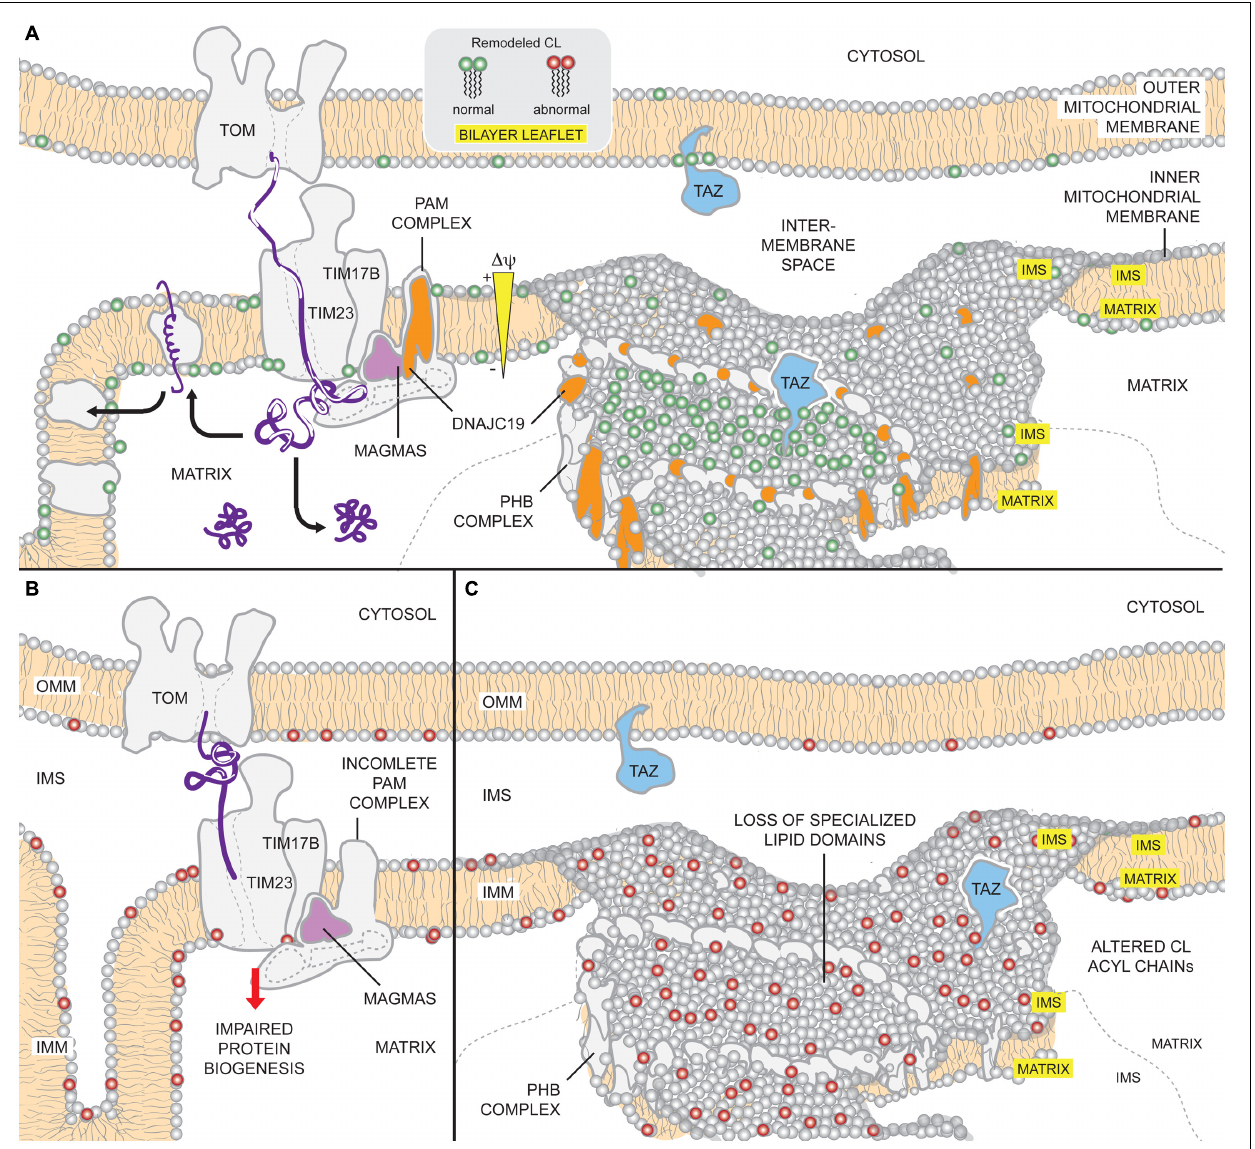
FIGURE 5 | Potential mechanisms of DCMA mitochondrial dysfunction. (A) Under physiological conditions, DNAJC19 is targeted to TIM17B by MAGMAS and associates with components of the TIM23 translocation machinery, forming translocase B. DNAJC19 is homologous to yeast Pam18p which stimulates the mtHsp70 activity of the PAM (presequence-associated motor) complex and stabilizes binding of incoming precursors. Moreover, DNAJC19 also interacts with prohibitin-2 (PHB) of the PHB complexes. PHB1/PHB2 oligomers form ring-like complexes that are modeled to delineate specialized membrane domains. Functional segregation of CL and TAZ in such domains may confer acyl chain specificity to TAZ, allowing it to perform physiologically relevant CL